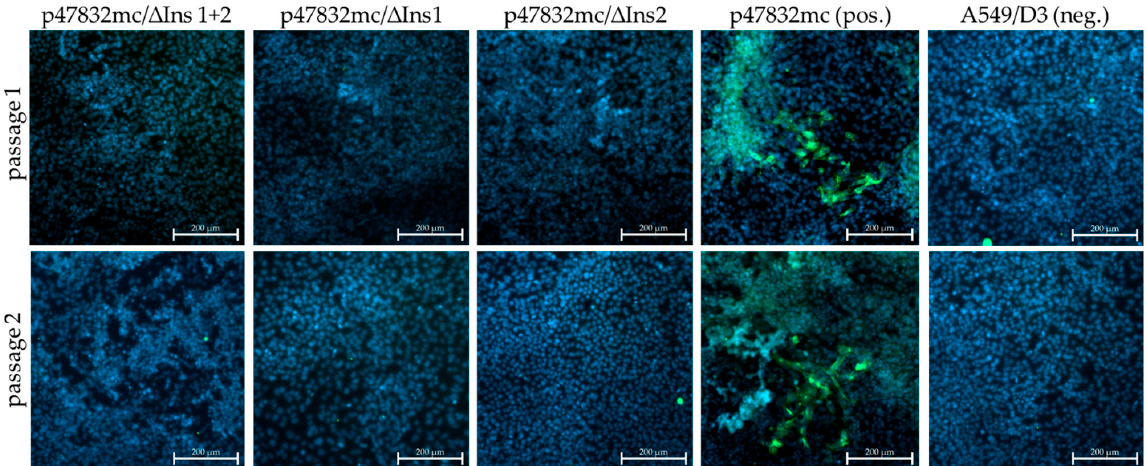
Figure 2. Testing of constructs containing deletions in the insertion region of the HVR of strain 47832c. The indicated constructs were transfected into BSR T7/5 cells and the resulting cell lysate was used for passaging on A549/D3 cells. The A549/D3 cells from the first (passage 1) and second (passage 2) passage are shown, which were analyzed by immunofluorescence using an HEV capsid protein-specific antiserum. Green signal: HEV capsid protein, blue signal: nuclear DAPI staining. Scale bar: 200 µm.